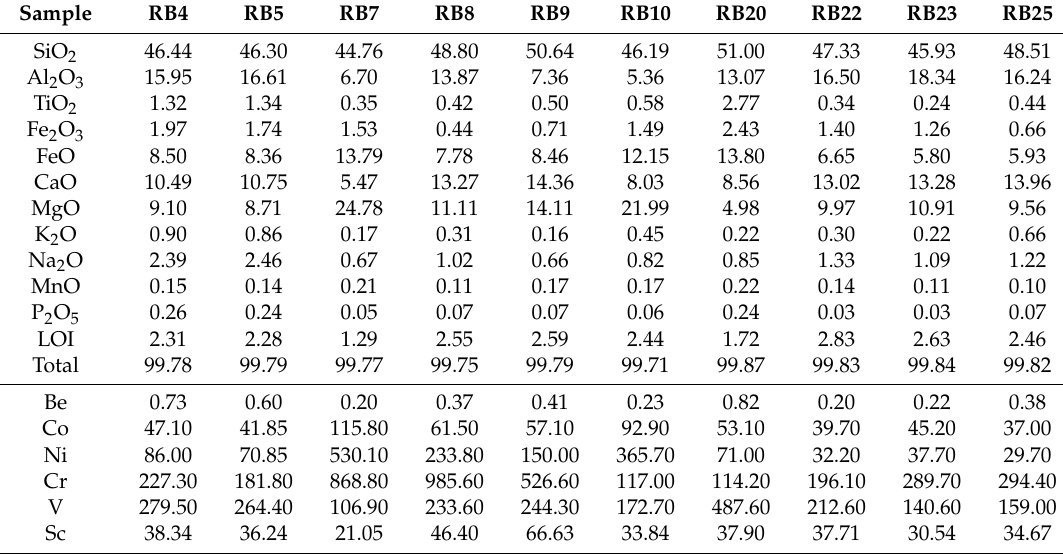
Table A2. Major (wt.%) and trace (ppm) element compositions for the Haoyaoerhudong gabbro.